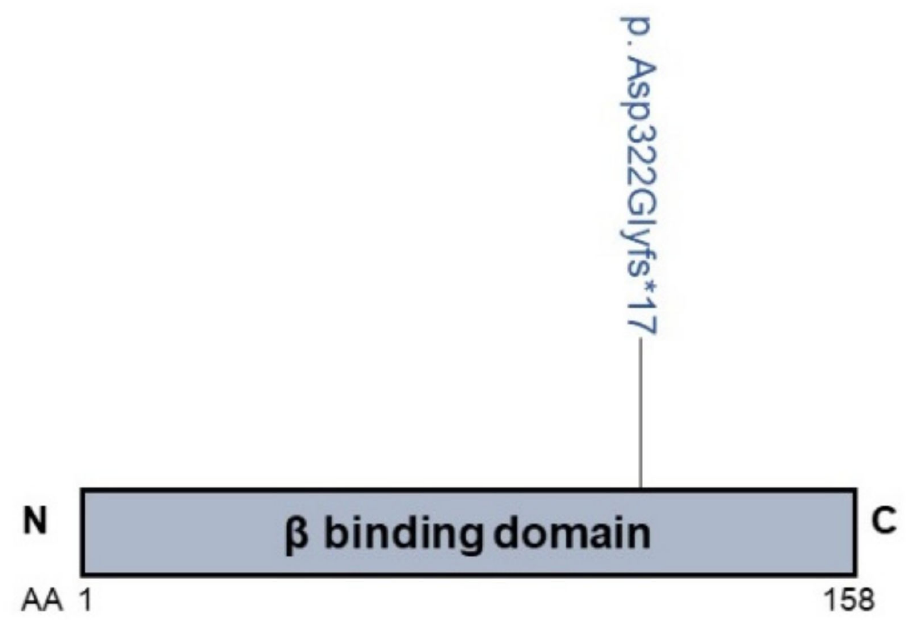
Figure 6. Cholestasis-associated AP1S1 mutation. The beta-binding domain (responsible for interac- tion with the beta-subunit of the AP1 complex) is shown. N: aminoterminus; C: carboxylterminus; AA: amino acid; *: premature